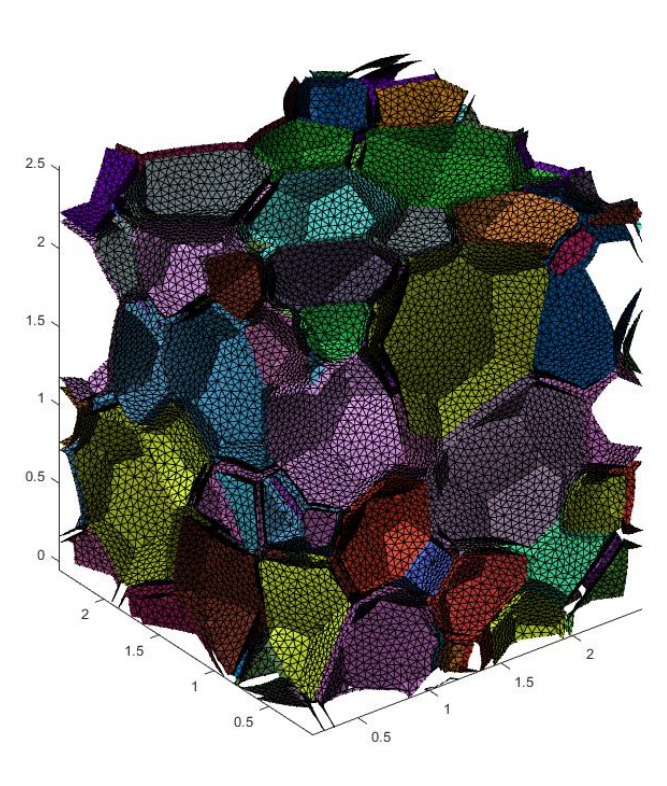
Figure 4. Full cell structure showing the spaces between cells (wall thickness) in 3D.